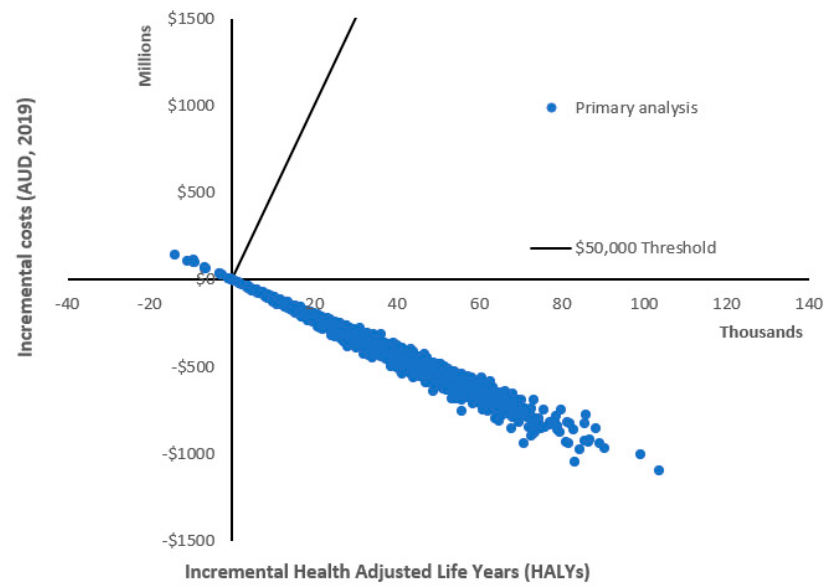
Figure 2. Cost-effectiveness plane for the primary cost–utility analysis. The difference in perspective for the CBA and CUA produced marked